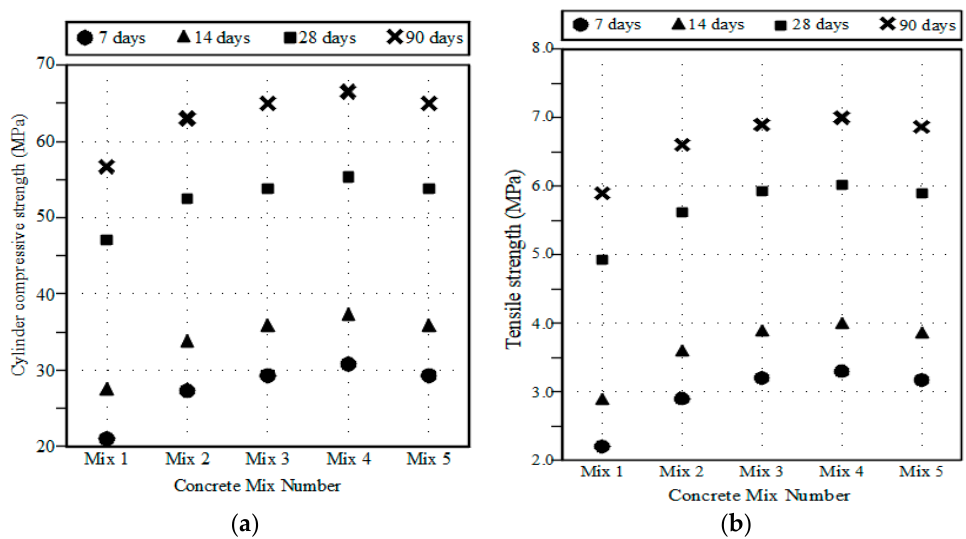
Figure 2. Test specimens’ strengths. ( a ) Cylinder compressive strength; ( b ) Tensile strength.